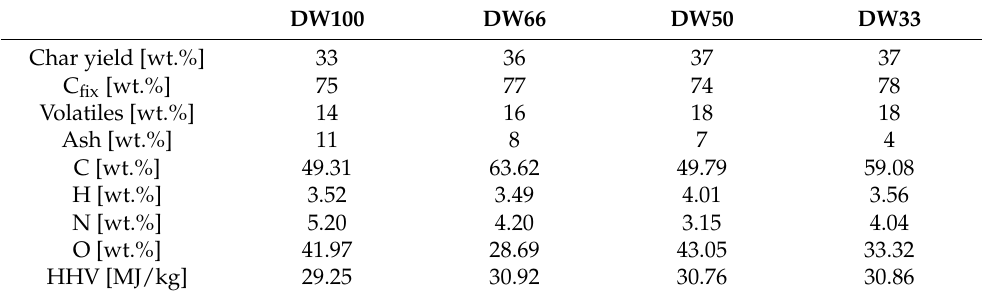
Table 2. Characteristic of carbonization products for different distillery waste content in the pellets.